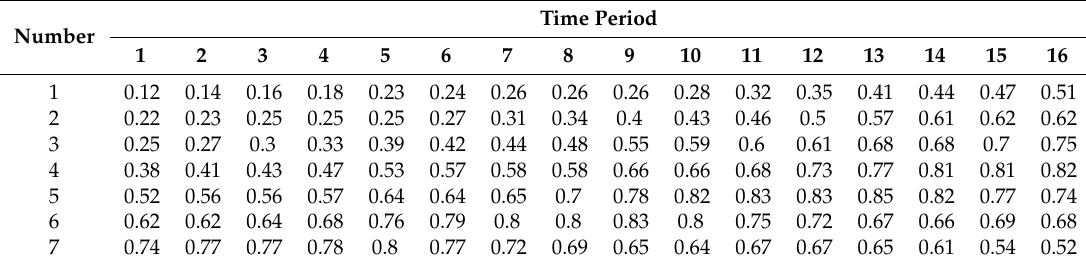
Table A2. The intra-day rolling predicted wind power data (p.u.).